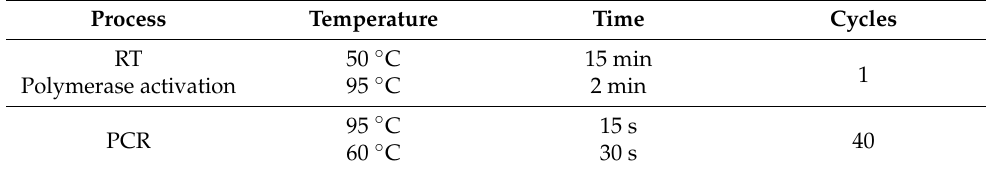
Table 2. RT-qPCR